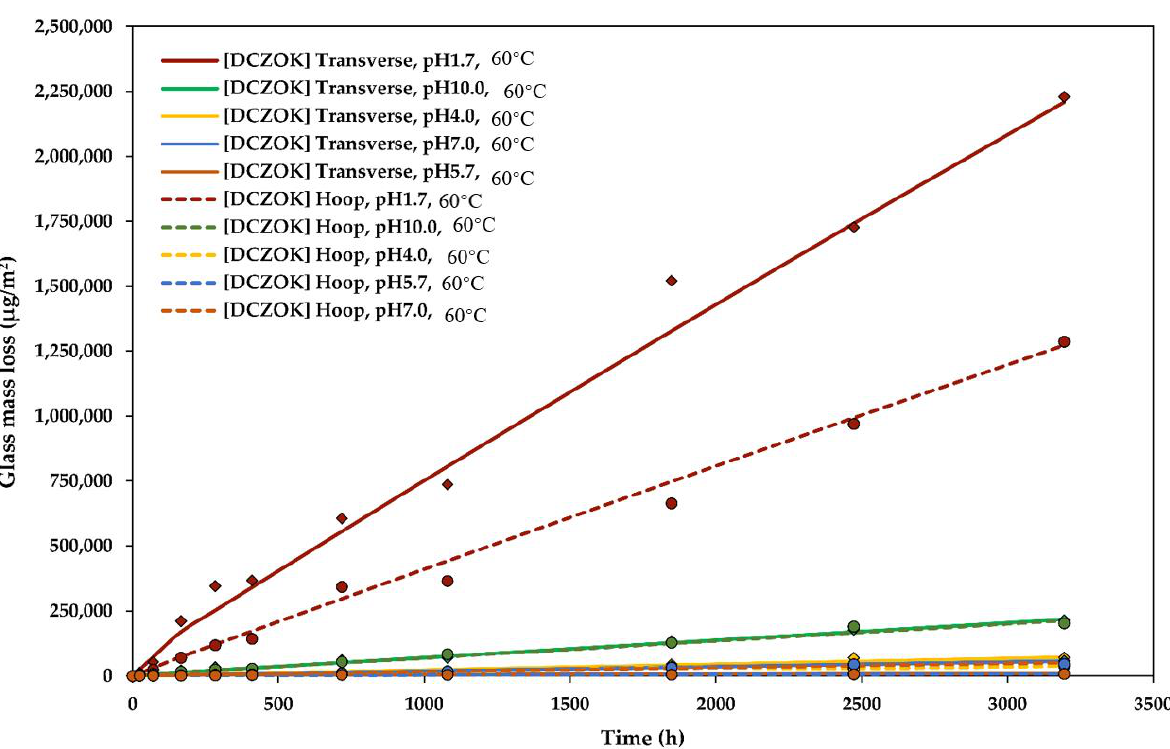
Figure 10. Glass dissolution kinetics at various pH levels: experimental data and modeled DCZOK dissolution curves for GFRP plates.